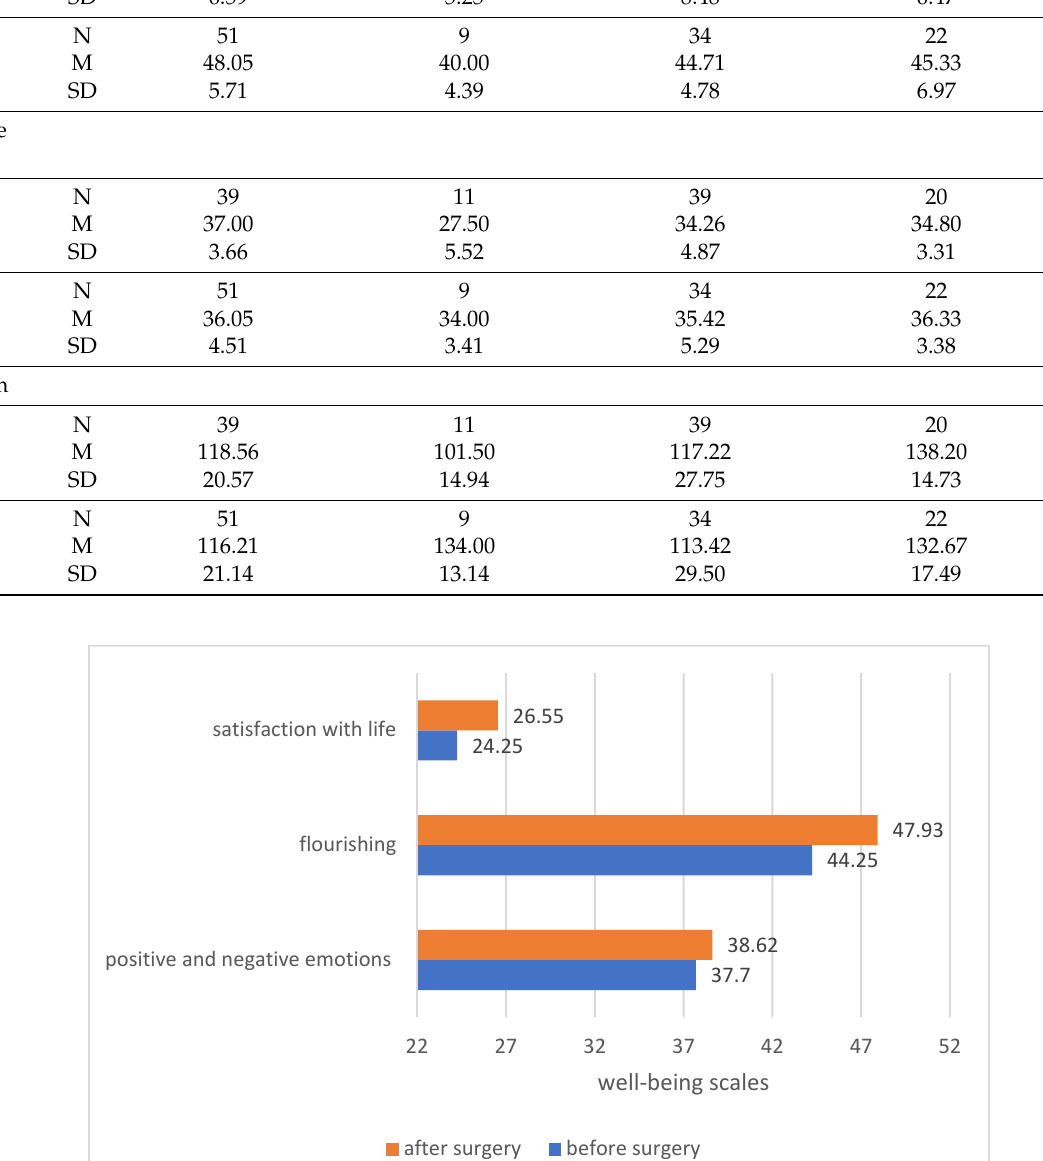
well-being scales after surgery before surgery Figure 11. Comparison of various forms of patients’ well-being before and after the procedure. Basic descriptive statistics for the three types of well-being, self-esteem and subjec- tive self-esteem of patients are presented in Table 9. Table 9. Basic descriptive statistics of the researched quantitative variables.